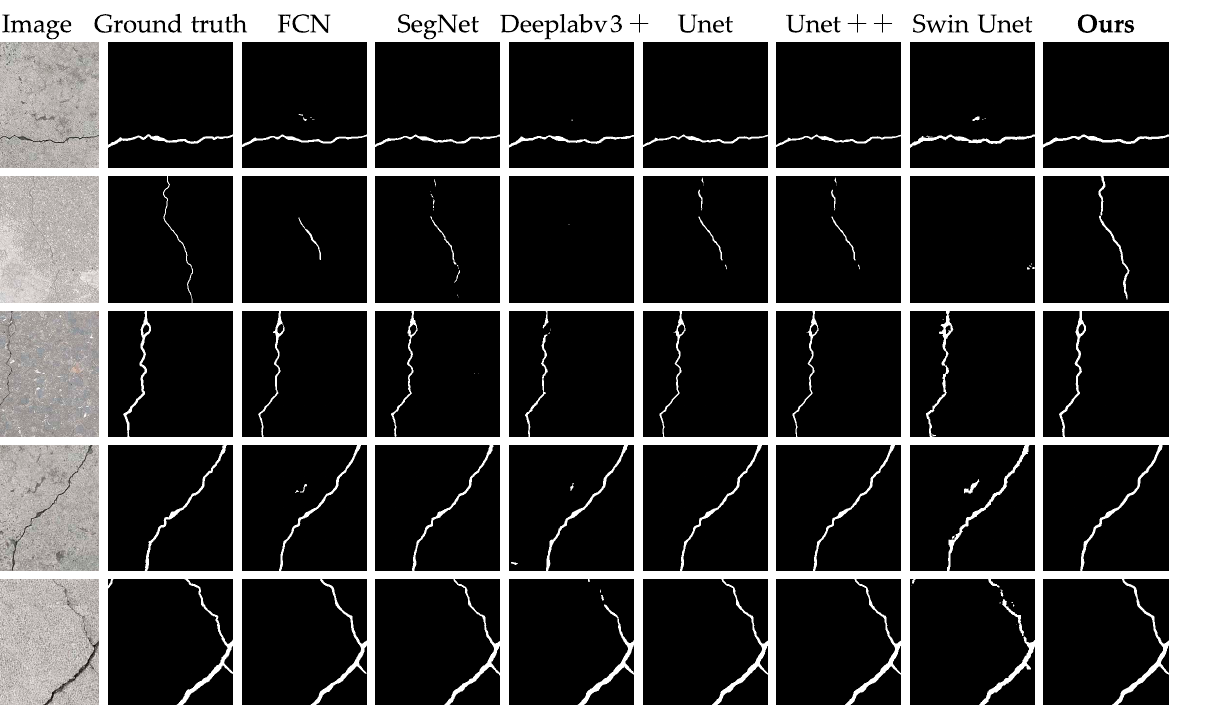
Figure 9. Samples of crack detection using different networks.